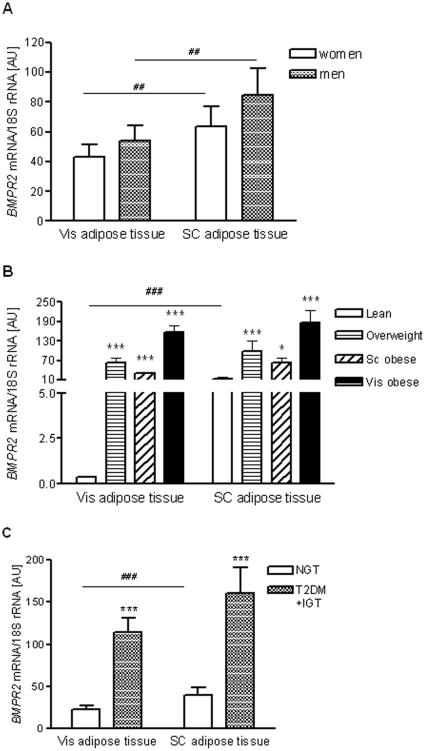

BMPR2 mRNA expression in visceral (Vis) and subcutaneous (SC) adipose tissue in lean, obese and type 2 diabetic subjects.The data are means ±SEM; BMPR2 mRNA levels in (A) men (N = 80) and women (N = 81), (B) subgroups of lean (BMI <25 kg/m2; N = 44), overweight (25 kg/m2 < BMI <30 kg/m2; N = 37), SC obese (N = 57) and Vis obese (N = 23) (BMI >30 kg/m2); (C) subjects with normal glucose tolerance (NGT; N = 116) and with impaired glucose tolerance (IGT; N = 15) or with type 2 diabetes (T2D; N = 30). * and *** indicate statistical significance at P<0.05 and P<0.001, respectively when compared with expression in lean subjects (Figure B) or in subjects with NGT (Figure C); # indicates statistical significance for differences between fat depots (Vis vs. SC) for appropriate subject groups; ## and ### indicate statistically significant at P<0.01 and P<0.001, respectively. AU, arbitrary units.